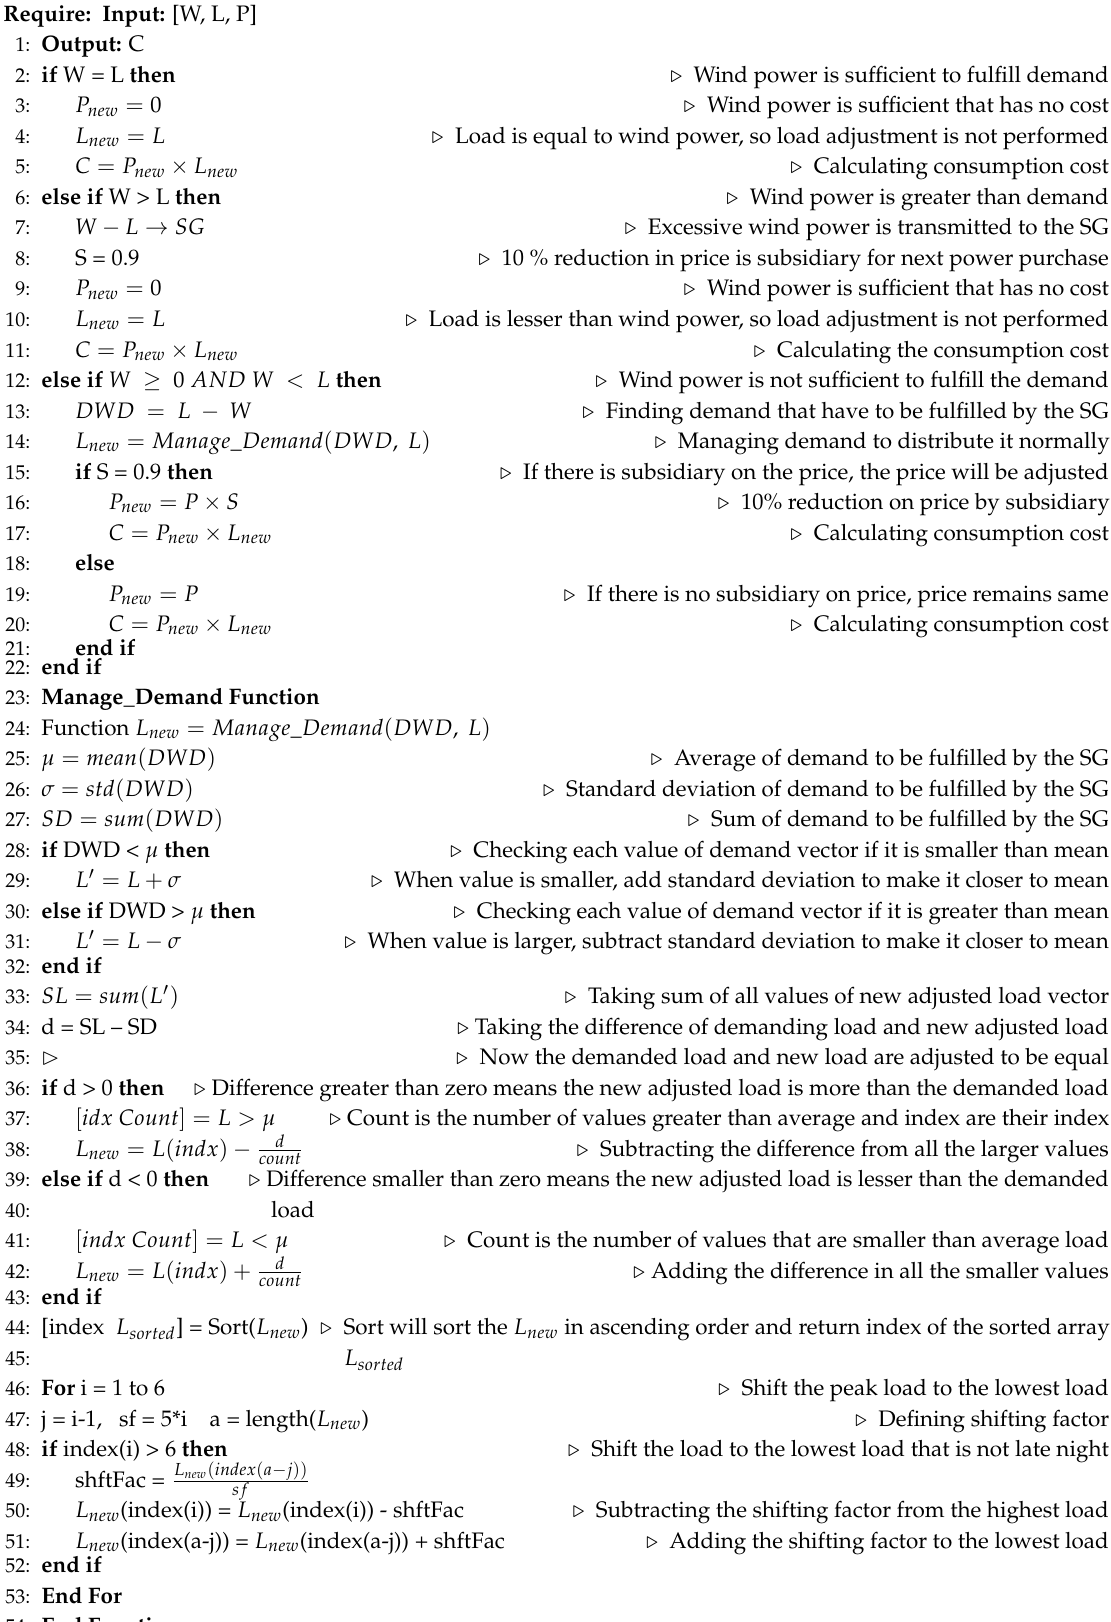
Algorithm 1 Algorithm for Demand Side Management